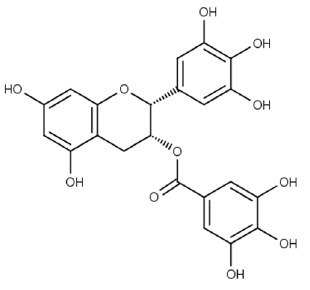
Figure 1. Structure of epigallocatechin gallate.